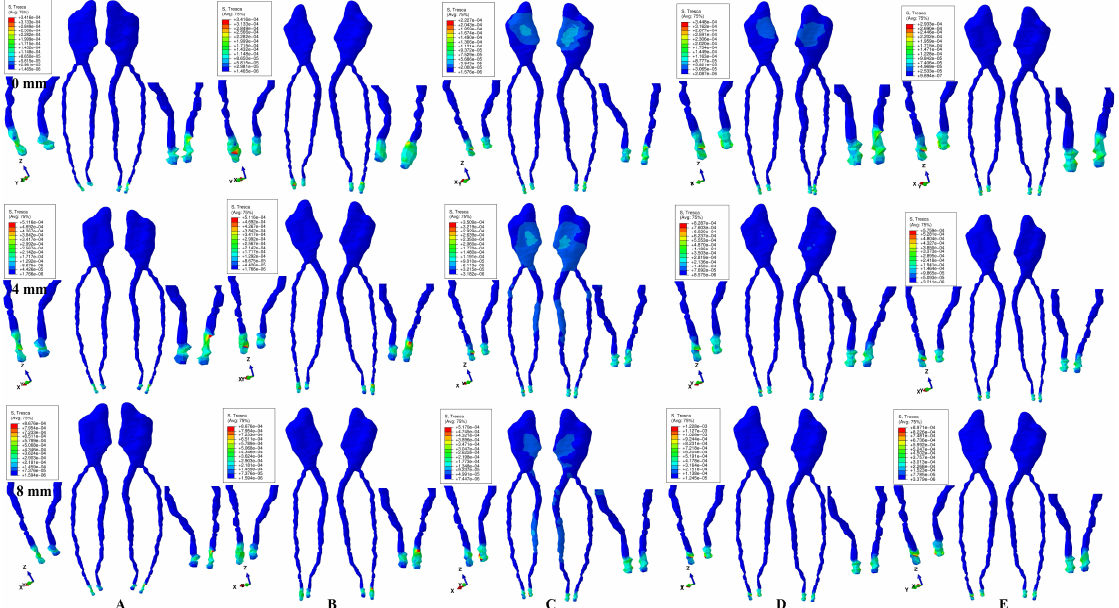
Figure 3. Tresca shear-stress display in dental pulp with its apical NVB (distal-vestibular and mesial-lingual, global, and detailed views) for 1.2 N (the quantitative values are in MPa) (intact, 4 mm and 8 mm reduced periodontium): ( A ) intrusion, ( B ) extrusion, ( C ) translation, ( D ) rotation, ( E ) tipping; the highest stressed areas are color-coded in red and orange. Table 2. The Tresca shear-stress average values (KPa) produced by 0.6 N of orthodontic forces.